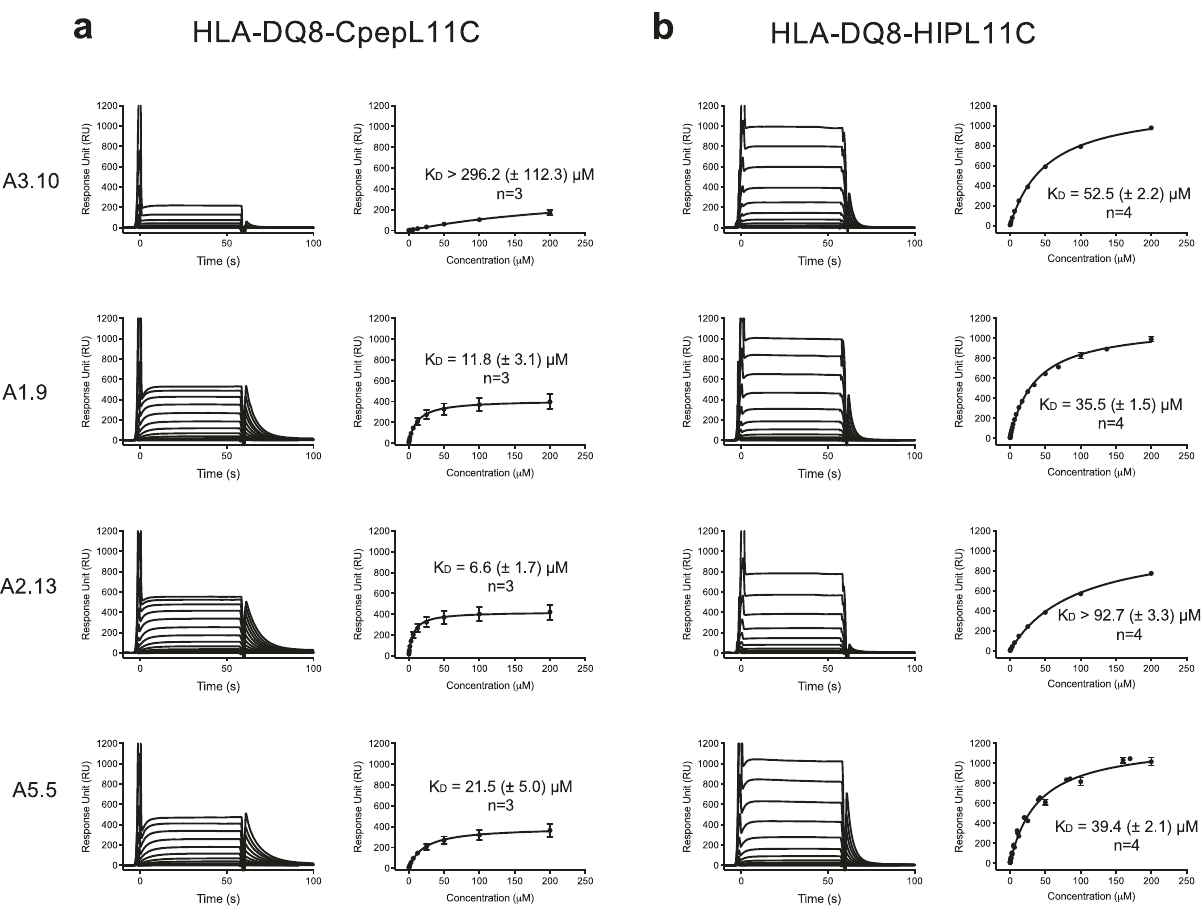
Fig. 3 Af fi nity determination for the HLA-DQ8-CpepL11C/HIPL11C restricted TCRs. Binding analysis of TCRs A3.10, A1.9, A2.13, and A5.5 for a HLA- DQ8-CpepL11C and b HLA-DQ8-HIPL11C was determined using SPR. A concentration series from 200 μ M to 0 μ M of each TCR was passed over surface immobilised a HLA-DQ8-CpepL11C and b HLA-DQ8-HIPL11C. Left columns in a and b : measured response curves of the single dilution series for each TCR. Right columns in a and b : Curve fi ts for TCR-HLA-DQ8-CpepL11C/HIPL11C and K D determination using single ligand binding model. Each TCR sample was analysed in duplicate, and three ( n = 3) or four ( n = 4) (as indicated) independent experiments were conducted and measurements were combined after normalising each equilibrium response curve against the calculated response maximum. Data are mean ± standard error, s.e.m. Source data are provided as a Source Data fi